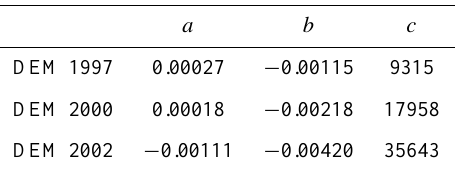
Table 4. Weights used to place the DEMs in the same plan as DEM